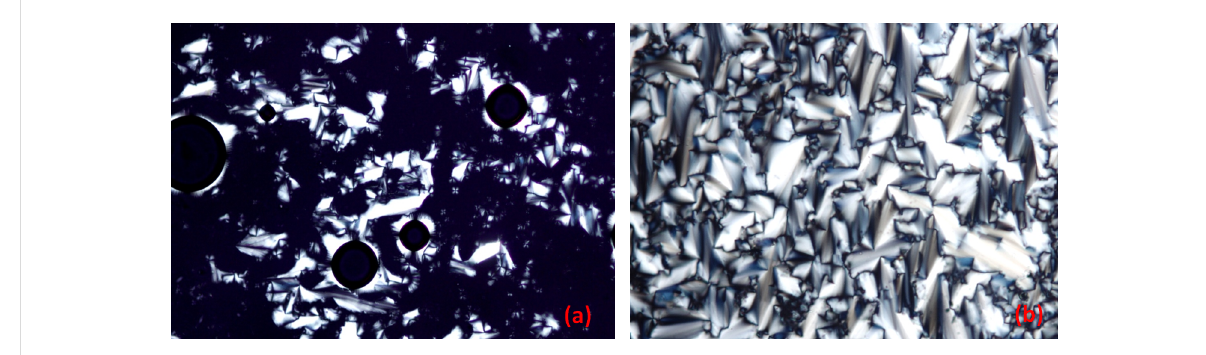
Figure 2: POM pictures of [bisC 8 ImC 10 ][C 12 H 25 OSO 3 ] 2 on cooling from the isotropic state: at 318 K (a) and at 303 K (b).